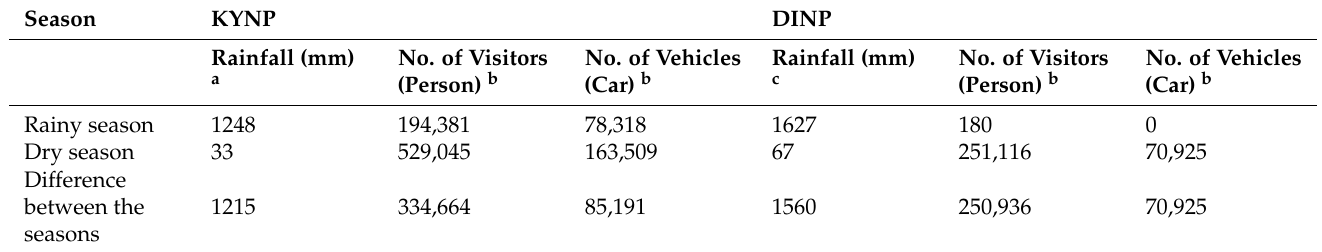
Table 2. Amount of rainfall, number of visitors, and number of vehicles during the study period during the rainy and dry seasons in Khao Yai National Park (KYNP) and Doi Inthanon National Park